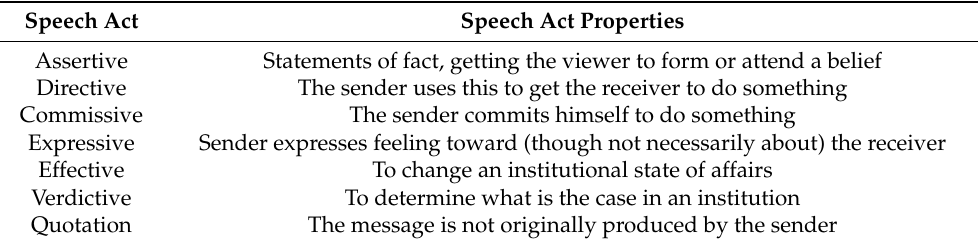
Table 1. Framework of speech act